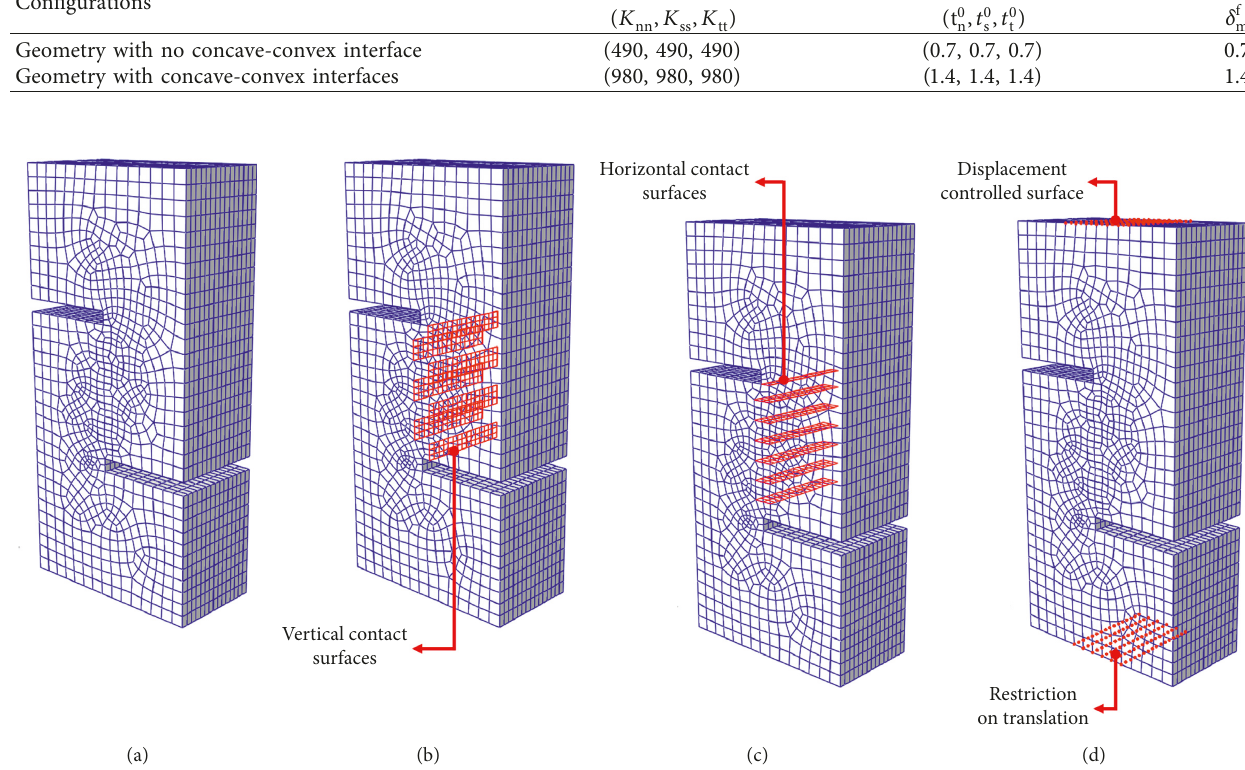
Table 11: Finite-element analysis model convergence criteria